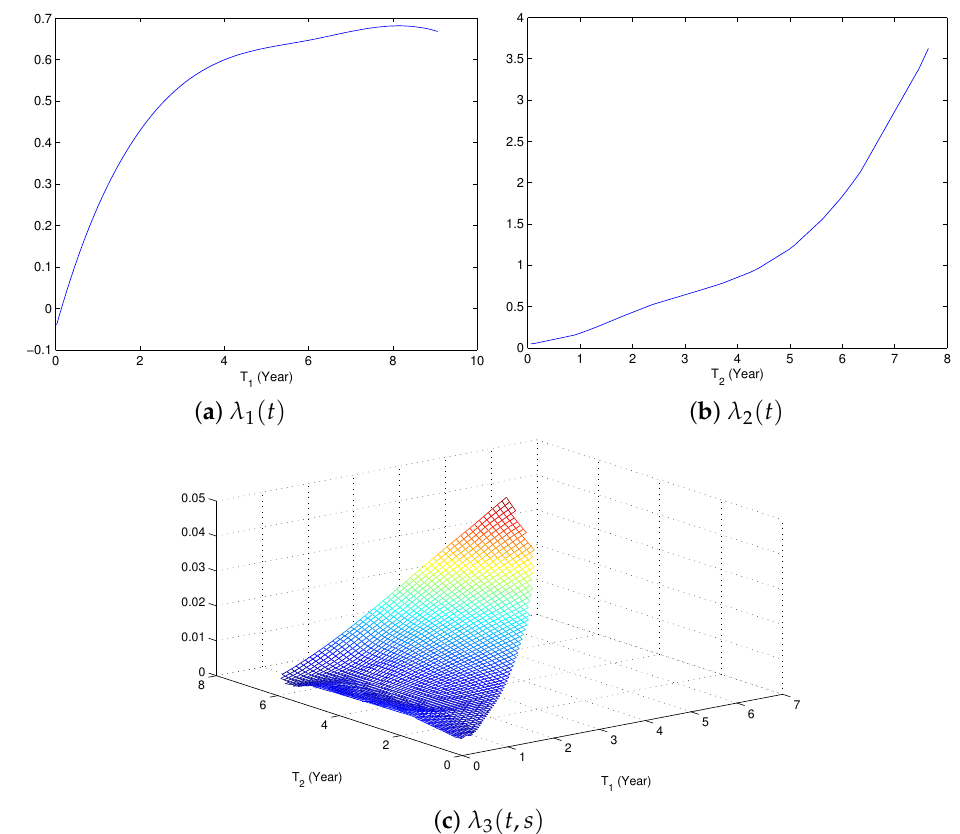
Figure 2. Estimated transition functions for the colon cancer